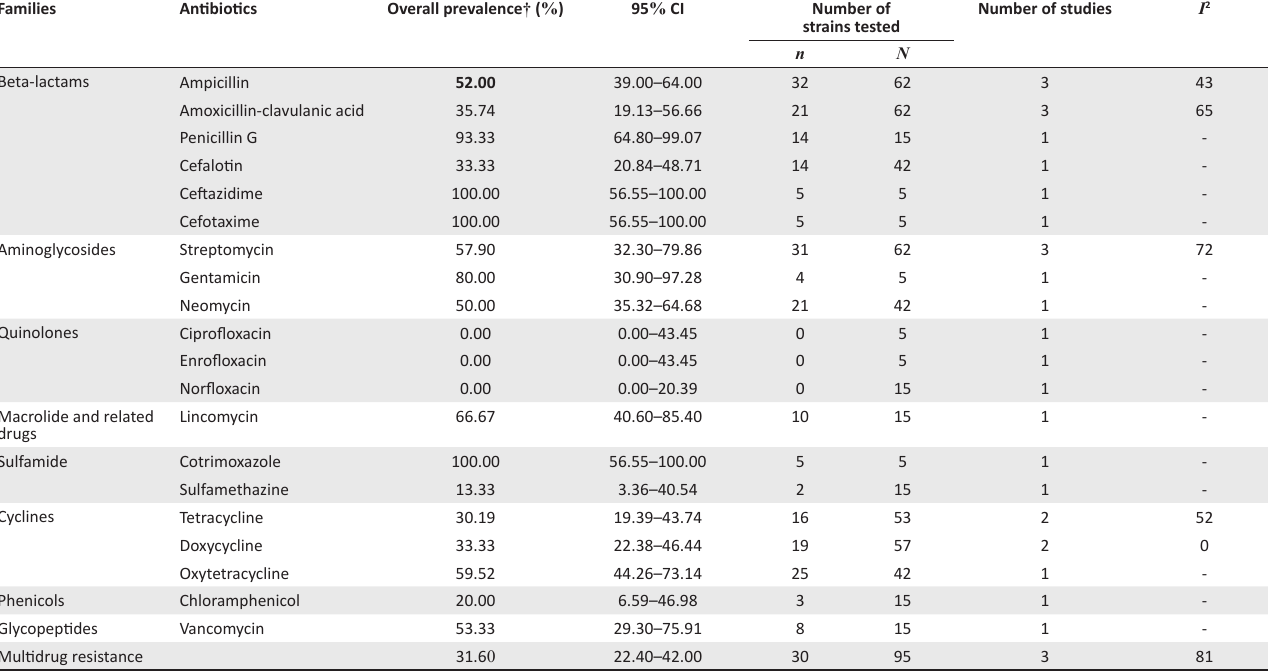
TABLE 4: The overall prevalence of antibiotic resistant Salmonella strains isolated from dogs in Africa. Families